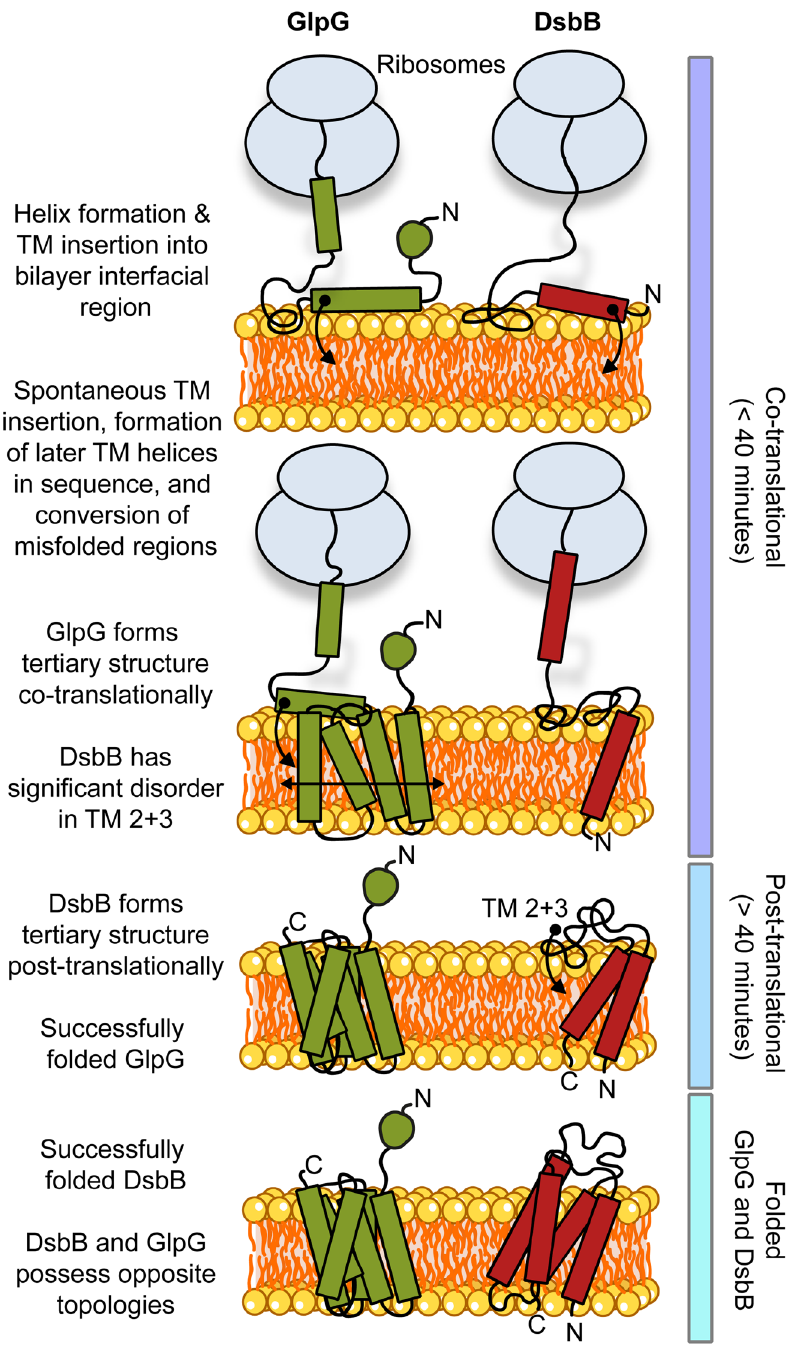
Figure 6. Schematic of postulated co-translational folding pathways for GlpG and DsbB unaided by membrane insertion apparatus. Suggested routes are supported by a combination of time-resolved SEIRAS (Figs 3 and 4 and S3), MPEx analysis (Fig. 5), the crystal structures (Fig. 1), and AMS labelling (Fig. 2). This is only a postulated, simple folding scenario that is consistent with our data. From our protein synthesis rate measurements (Fig. S4), we propose any events < 40 minutes observed by SEIRAS are co-translational, whereas events > 40 minutes are progressively post-translational. GlpG forms helices and inserts into the bilayer co- translationally, folding to form its polytopic tertiary structure during translation. Insertion is likely driven by the favourable thermodynamics for TM insertion, especially the leading TM-1 and TM-2. In contrast, DsbB folds into its final polytopic form post-translationally, likely related to the less favourable thermodynamics for TM insertion of TM-2 and TM-3 compared to the more favourable TM-1 and TM-4 insertion. The N- and C- termini are labelled N and C respectively. GlpG is shown in green (left) and DsbB in red (right), with the nascent polypeptide chain shown in black and folded helices shown as coloured rectangles; the circular shape at the GlpG N-terminus represents its cytoplasmic domain which possesses some β